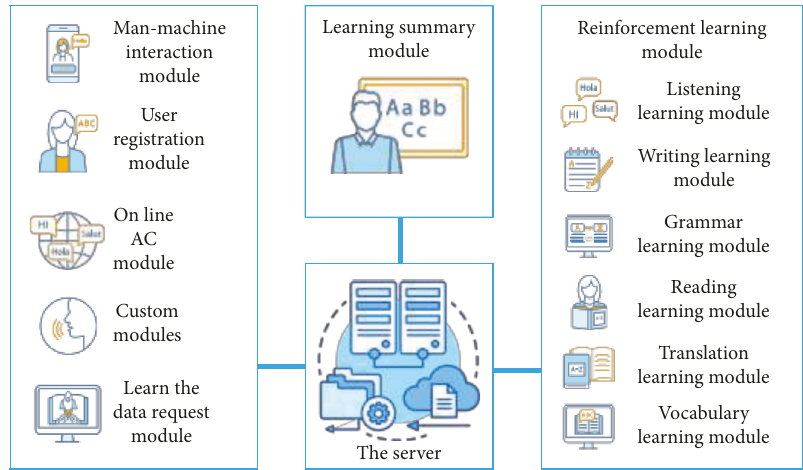
Figure 1: Oral English auxiliary teaching system based on Deep